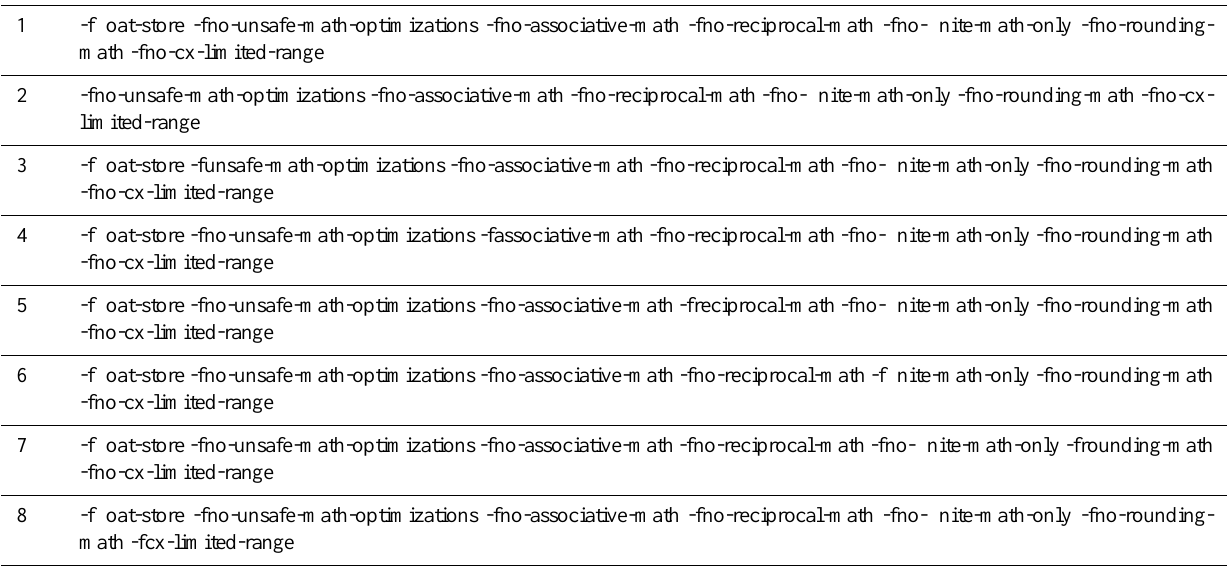
Table 7. GCC compiler flags that are based on the compiler optimization options listed in Table 5. The first compiler flag is the strictest one (which limits compiler optimizations most significantly), while every other compiler flag is derived from the first one through changing only one compiler optimization